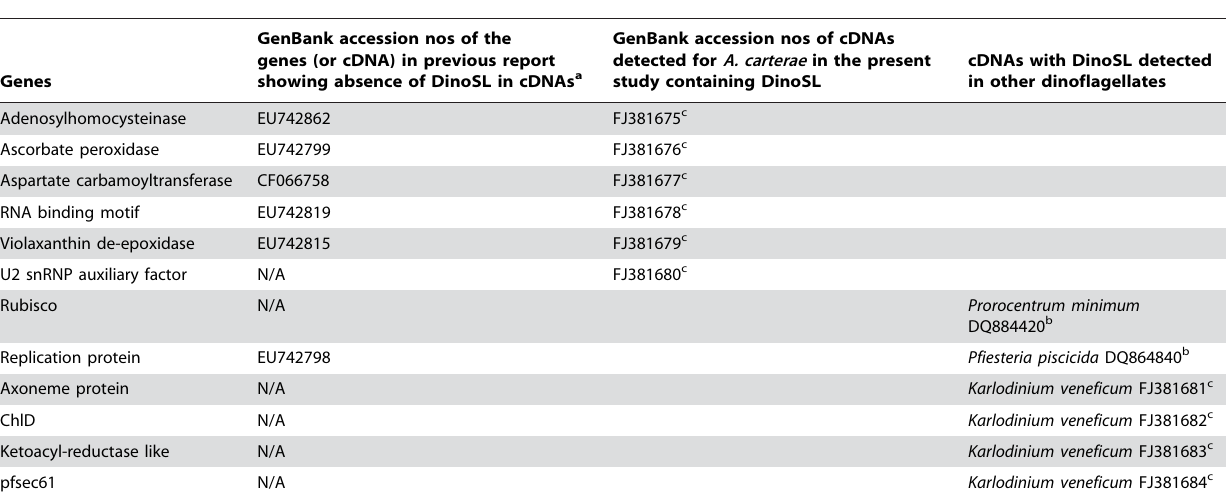
Table 2. Amphidinium carterae gene transcripts previously reported to lack DinoSL and the corresponding cDNAs with DinoSL obtained in our